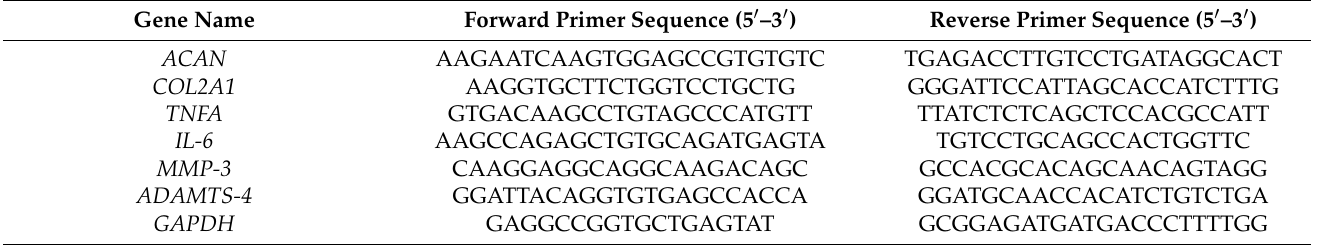
Table 1. Primer sequences used in the